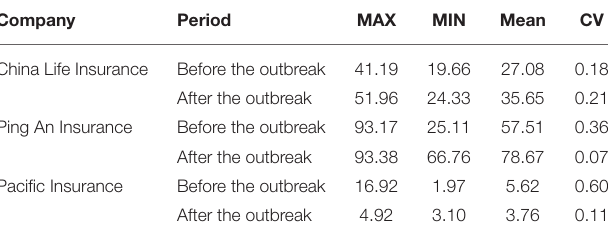
TABLE 1 | Descriptive statistics of the stock closing prices of three health insurance companies.